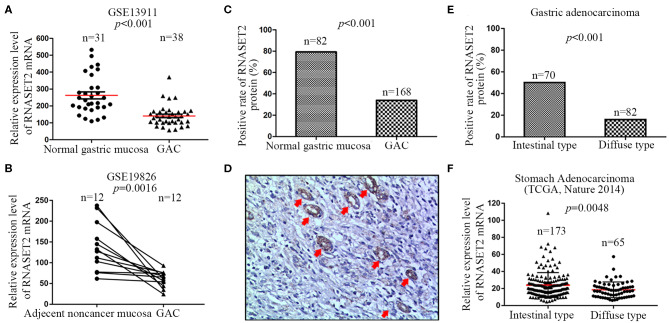
Differential expression of RNASET2 between GAC and adjacent non-cancerous or normal gastric mucosa tissues. (A) The dataset from GSE13911 showed the relative expression level of RNASET2 mRNA was decreased 2.29-fold in GAC tissues than that in normal gastric tissues (p < 0.001, Student's two-tailed t-test). (B) 12 paired GAC and adjacent non-cancerous gastric mucosa tissues from GSE19826 showed the relative expression level of RNASET2 mRNA was lower in GAC tissues than that in adjacent non-cancerous gastric tissues (p = 0.0016, Paired t-test, two-tailed). (C) Positive rate of RNASET2 protein in normal gastric mucosa and GAC tissues (p < 0.001, Chi-Square test). (D) Representative tissue specimens of RNASET2 protein expression in GAC and undamaged gastric mucosa glands; Red arrowhead represent undamaged gastric mucosa glands; DAB staining (brown); nuclear counterstaining (hematoxylin); original magnification, ×100. (E) Positive rate of RNASET2 protein in intestinal type GAC and diffuse type GAC tissues (p < 0.001, Chi-Square test). (F) TCGA stomach adenocarcinoma dataset (Nature 2014) showed the relative expression level of RNASET2 mRNA was decreased 1.30-fold in diffuse type GAC tissues than that in intestinal type GAC (p = 0.0048, Student's two-tailed t-test).